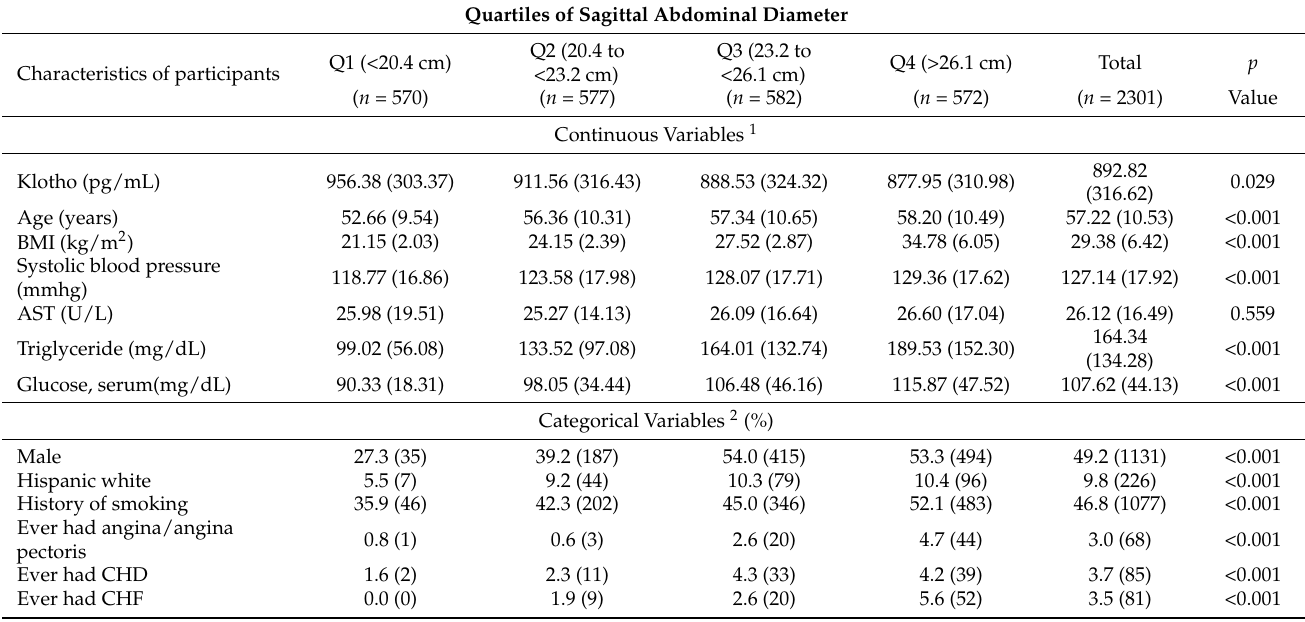
Table 1. Characteristics of participants for each quartile of sagittal abdominal diameter. Quartiles of Sagittal Abdominal